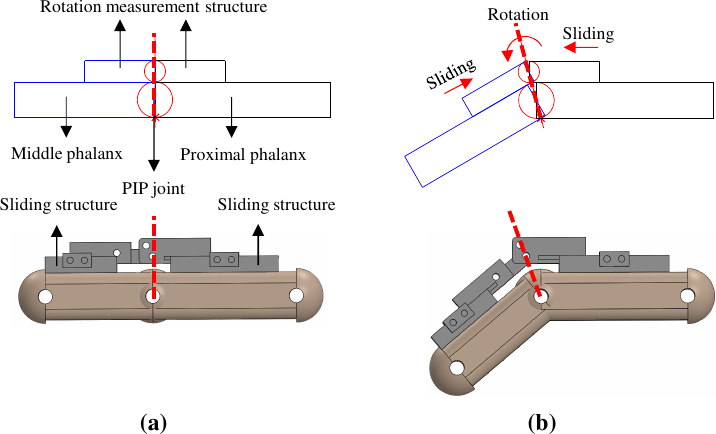
Figure 9. Necessity of sliding structures; ( a ) Initial position; ( b ) Rotated.